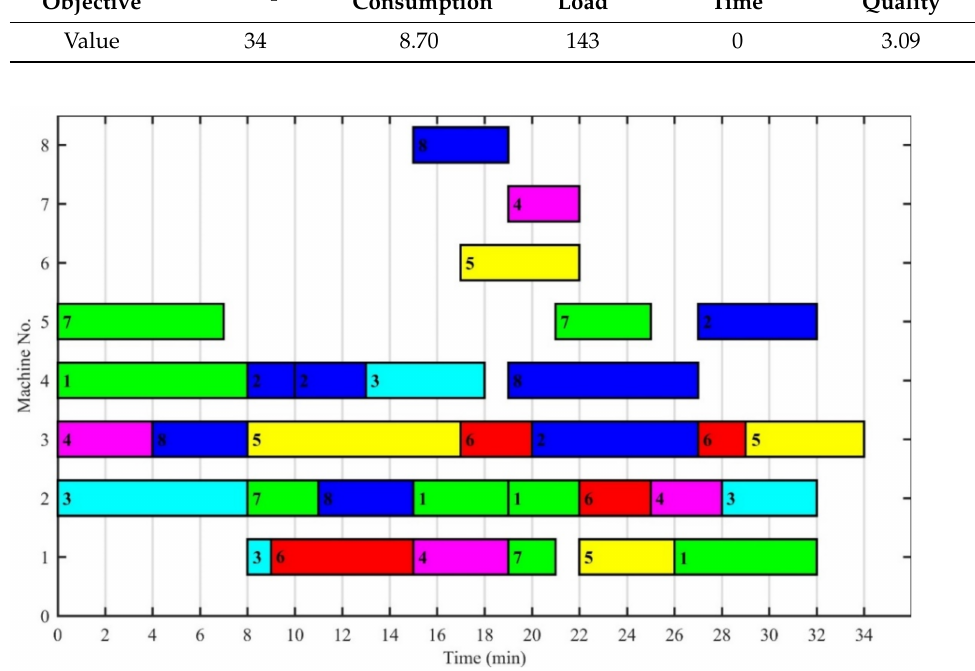
Figure 5. The scheduling